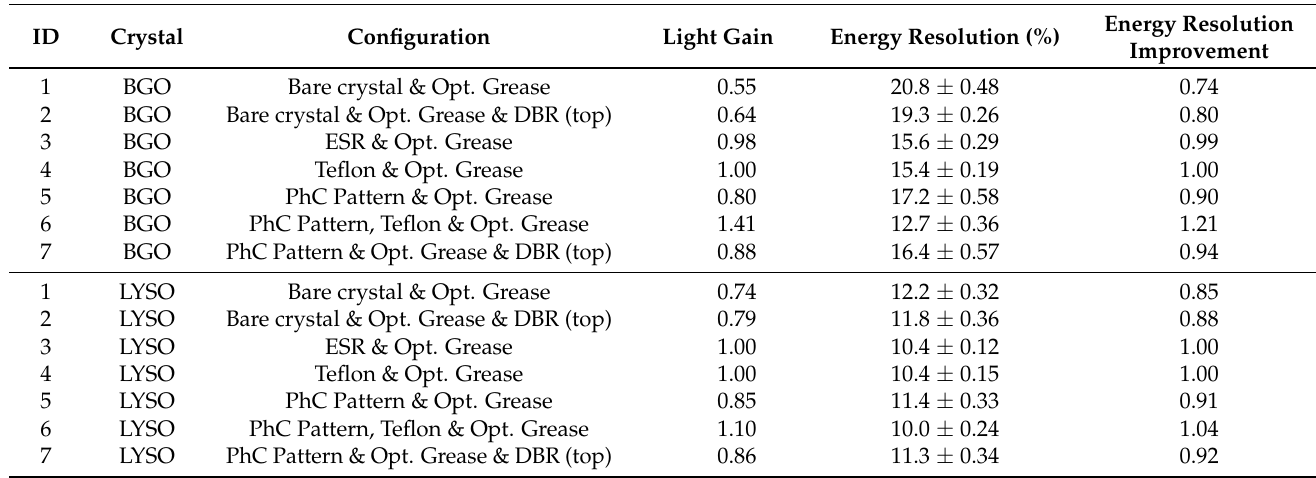
Table 1. Summary of all experimental results on 10 × 10 × 10 mm 3 BGO and LYSO crystals in seven configurations. Reference: A standard configuration featuring a bare crystal wrapped in Teflon (ID = 4). The scintillator was coupled in all cases to the photodetector using optical grease. The light gain and the energy resolution have been calculated on the first peak of the spectrum (511